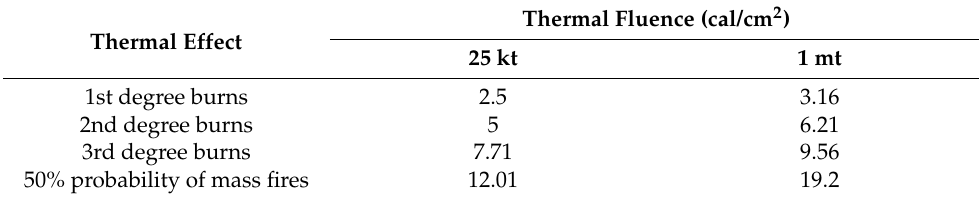
Table 2. Thermal fluence levels for 25 kt and 1 mt nuclear weapon.